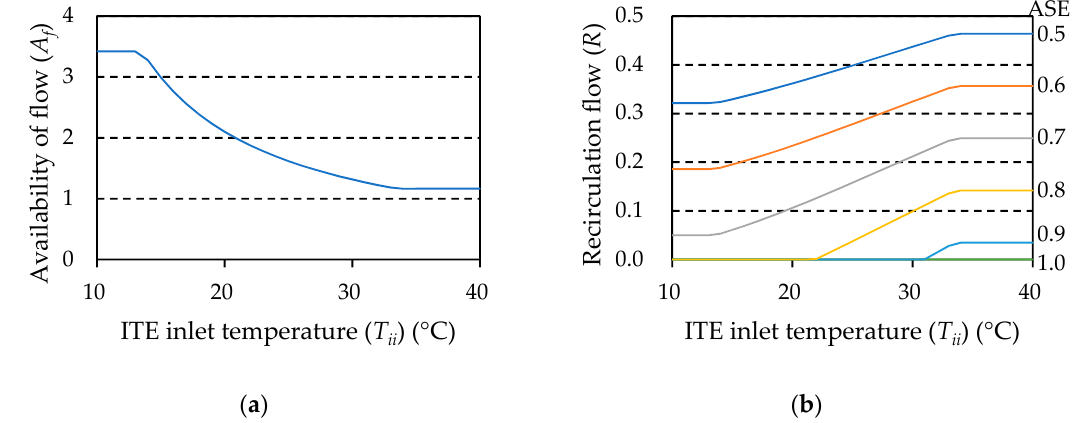
Figure 17. Air-performance metrics for ITE inlet temperature ( T ii ): ( a ) Availability of flow ( A f ) and ( b ) recirculation flow ( R ).